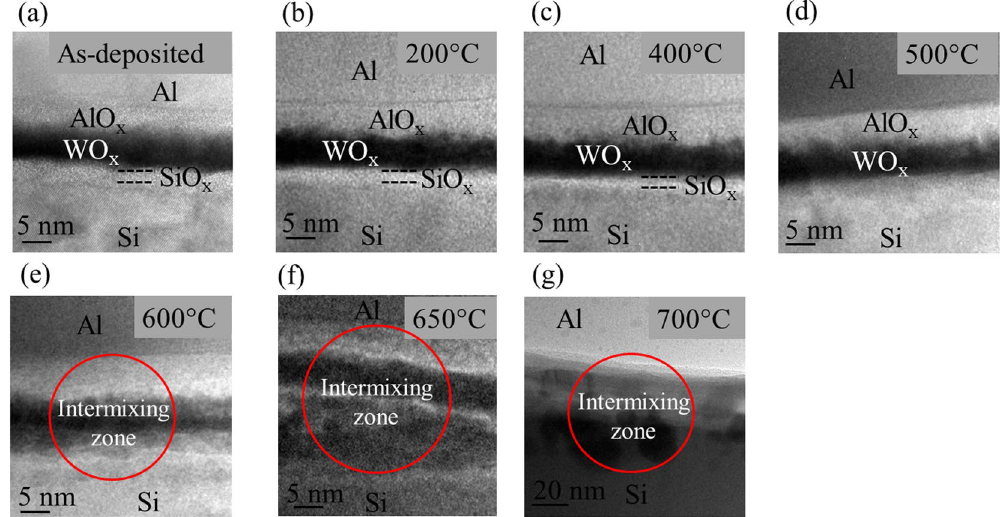
Figure 2. Cross-sectional HRTEM micrograph of c-Si/WO x /Al structure obtained by in situ TEM studies ( a ) as-deposited, ( b ) 200 °C, ( c ) 400 °C, ( d ) 500 °C, ( e ) 600 °C, ( f ) 650 °C, ( g ) 700